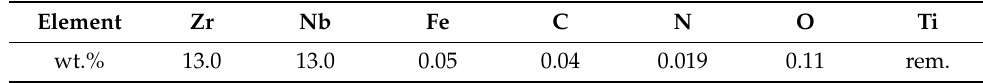
Table 1. The chemical composition of the Ti13Nb13Zr alloy, wt.%.